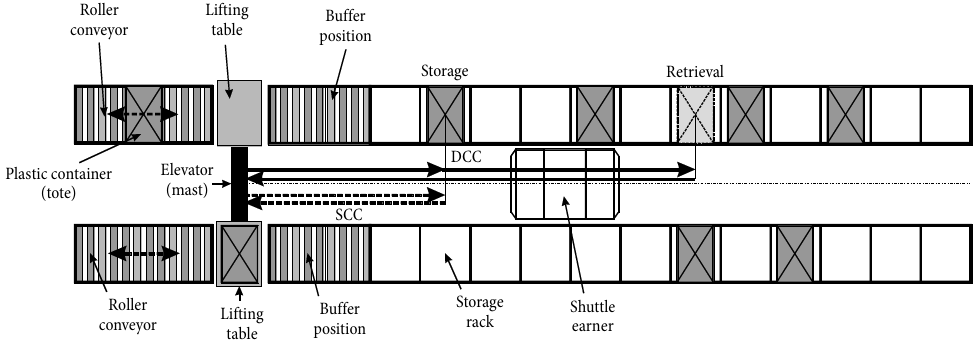
Fig. 3. SCC and DCC of the shuttle carrier (Lerher et al.